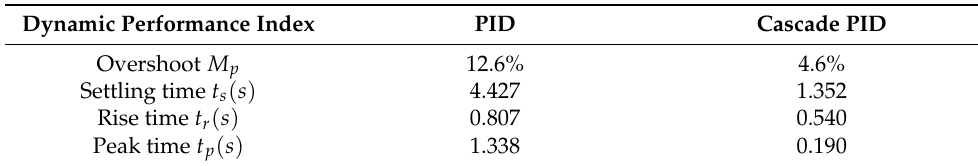
Table 3. Dynamic performance indicators of single-stage/cascade PID.